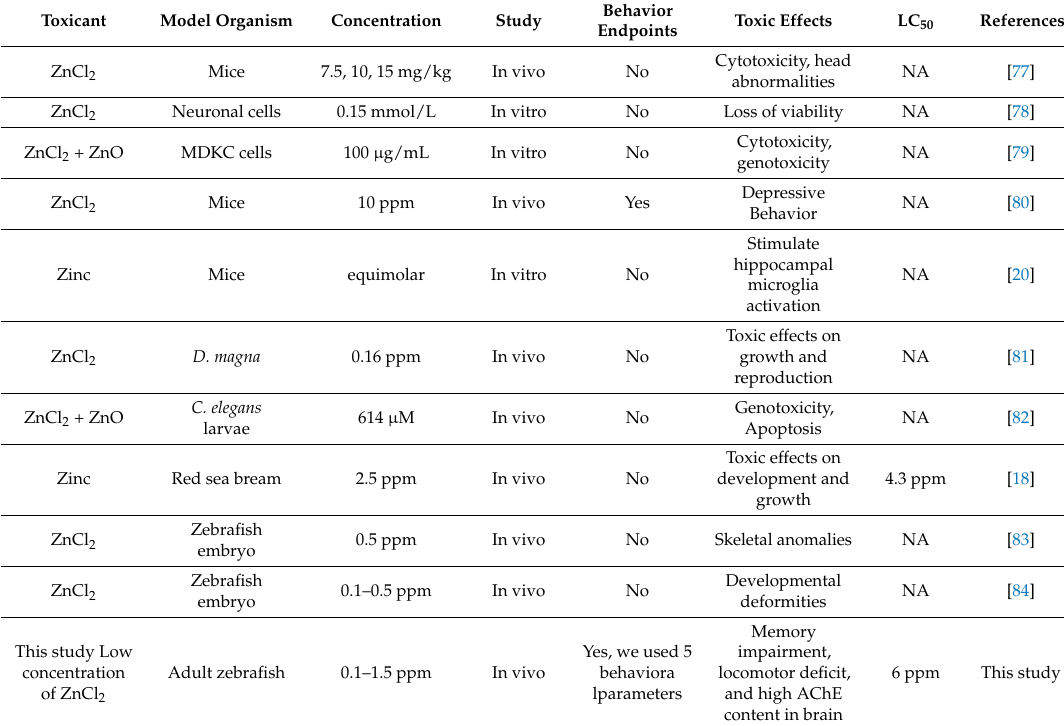
Table A1. Comparison of present study with other animal models exposed to ZnCl 2